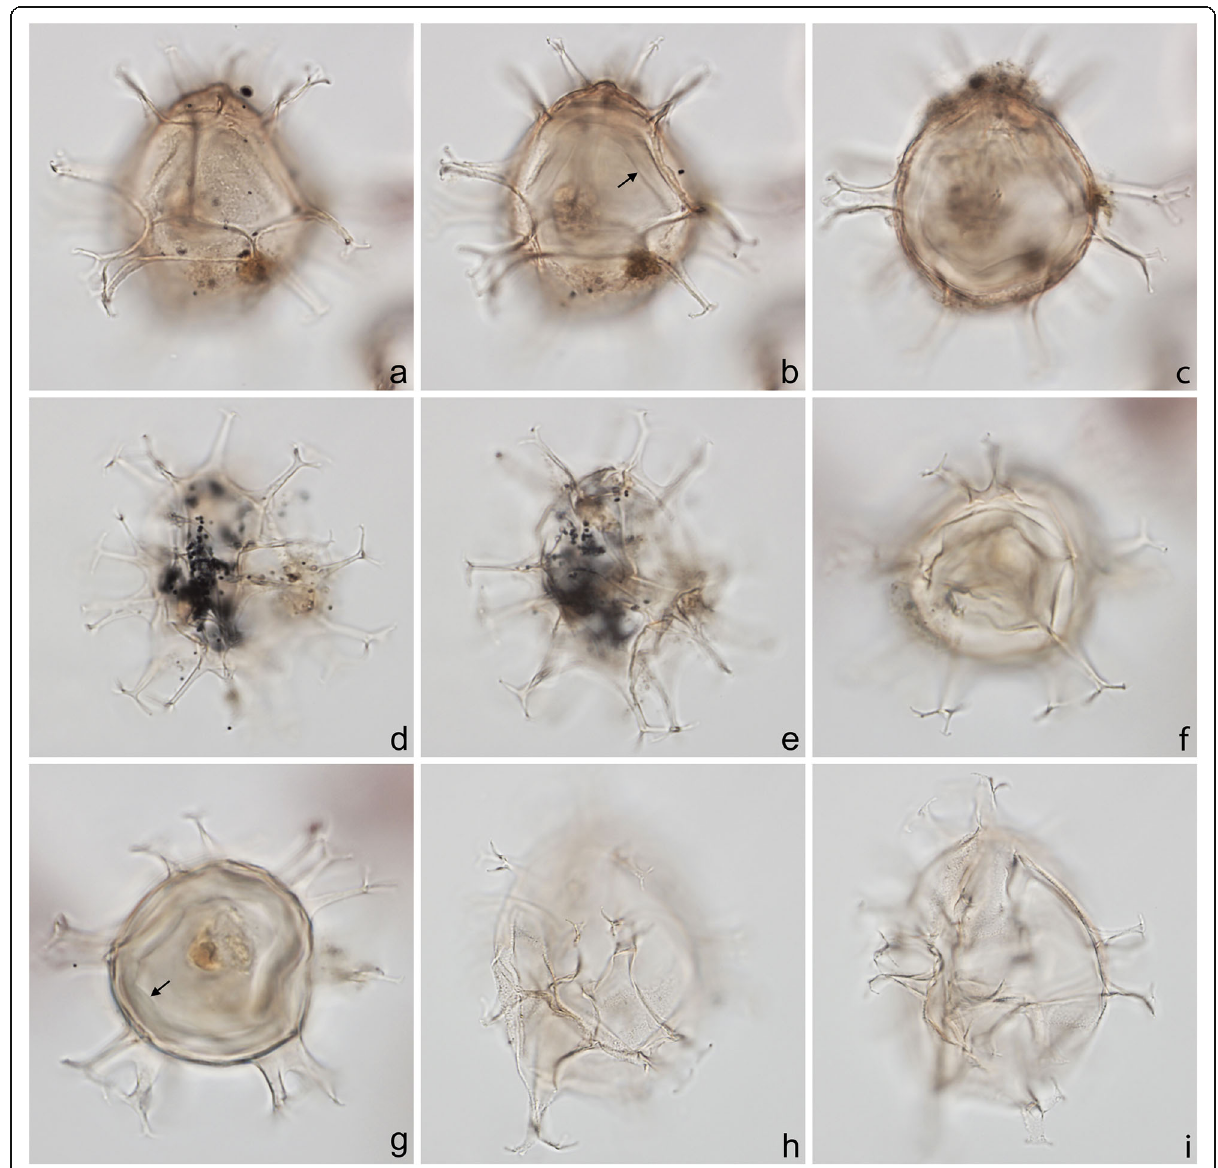
Fig. 7 Dinoflagellate cysts from the Chiba composite section. Max. dia. = maximum diameter. EF = England Finder reference. a – c Spiniferites pachydermus sensu Mertens et al. (2015), dorsal view at upper (operculum in place), slightly lower and mid-focus; note apical protuberance and preserved endospore (arrow); central body length 43 μ m, central body width 38 μ m; sample TB2 00, slide 1 (10 μ m) MJH, EF V16/4. d , e Spiniferites ramosus sensu Rochon et al. (1999), ventral-left-lateral view at upper and lower foci; central body length 33 μ m; sample TB2 97, slide 3 (20 μ m) MJH, EF M32/4. f , g Spiniferites sp. (a representative of Spiniferites spp. group A), apical view at upper and mid-foci, note preserved endospore (arrow); central body max. dia. 30 μ m; sample TB2 97, slide 2 (10 μ m) MJH, EF F13/0. h , i Spiniferites sp. B, view uncertain at upper and mid-foci; thin wall with distinctly granular periphragm surface; some processes tips petaloid; central body length 56 μ m; sample TB2 97, slide 3 (20 μ m) MJH, EF